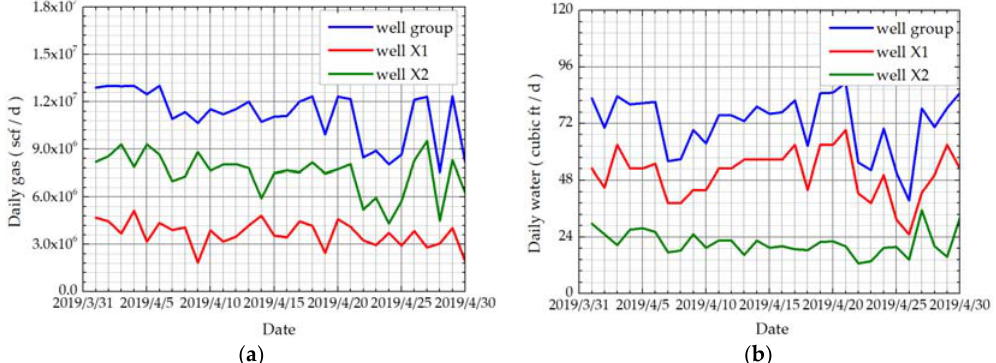
Figure 10. The ( a ) daily gas production data and ( b ) daily water production data of the well group for 30 days.